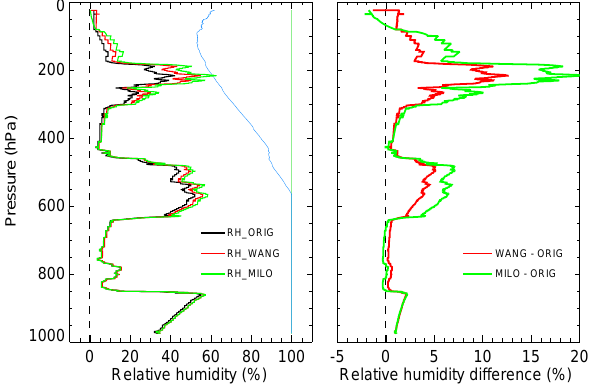
Figure 1. A comparison of the WANG- and MILO-corrected RH profiles (left plot; red and green, respectively) compared to the orig- inal RH profile (black). The light blue line represents the satura- tion RH with respect to ice. The right plot shows the difference between the original RH profile and the WANG/MILO RH profiles (red/green), respectively. This example is the 18Z sounding for the SGP site on 15 June 2006.